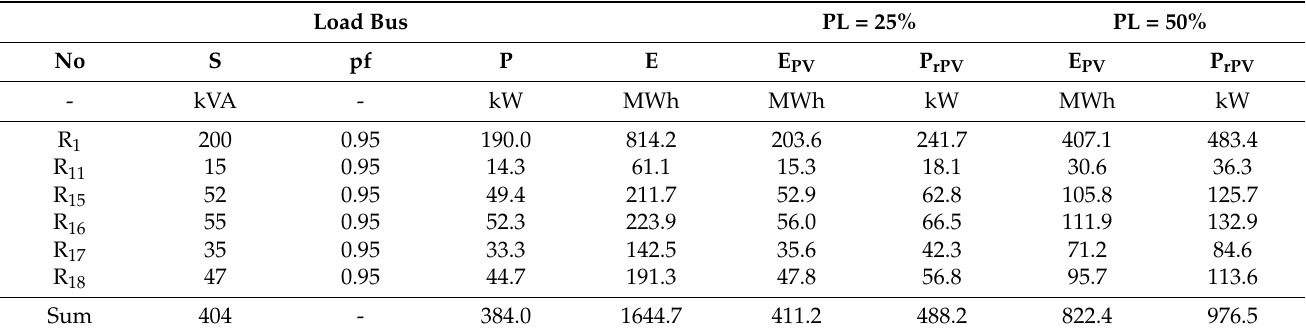
Table 1. Rated power of PV sources for two PV penetration levels.